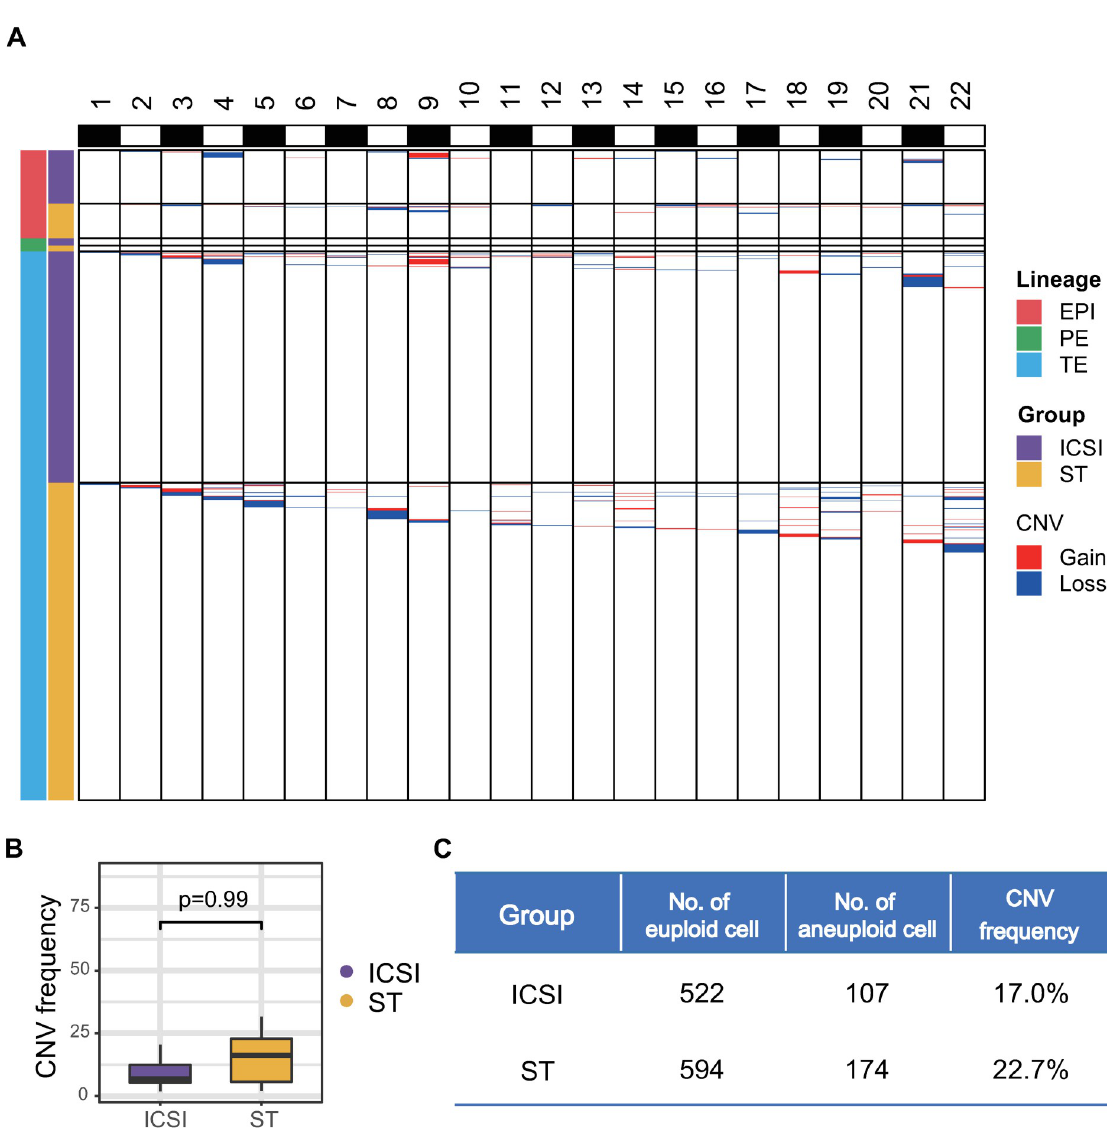
reduction method, MOFA inferred 5 hidden factors capturing the principal sources of biologi- cal variations in multiomics data (S8A Fig). The factor 1 and factor 2 (or factor 1 and factor 5) (ranked by variance explained) together captured the characteristics of 3 cell lineages best, which could divide the cells into 3 lineages (EPI, PE, and TE), and cells from the 2 groups were still clustered together (S8C Fig). And pairwise combination of the top 5 factors could not sep- arate the cells of ST and ICSI blastocysts (S8C Fig). Uniform manifold approximation and pro- jection (UMAP) analysis based on these factors also divided the cells into 3 cell lineages, and cells of ST and ICSI embryos were still clustered together (S8B Fig).